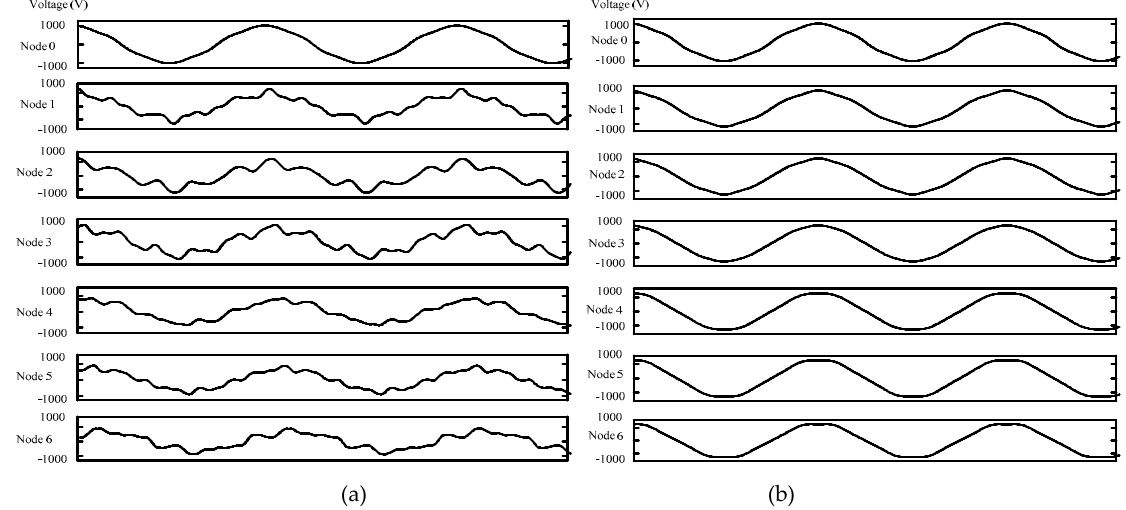
Figure 9. Voltage waveform with nonlinear load and background harmonic: ( a )VI-APF off, and ( b )VI-APF on.